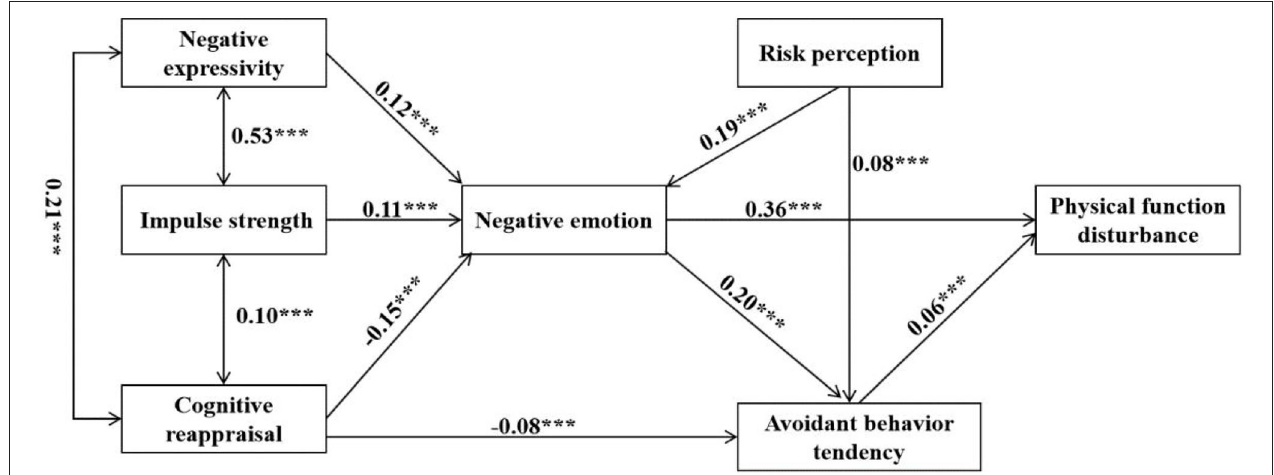
FIGURE 5 | The influential pathway of the negative emotion of frontline medical staff. *** p <